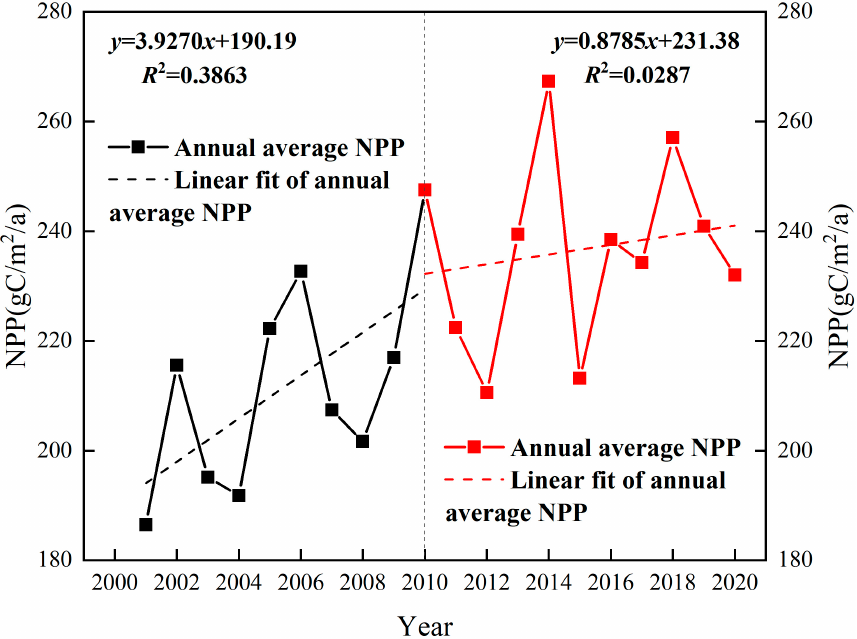
Figure 5. Trends in net primary productivity (NPP) in the Qinghai Lake Basin from 2001 to 2020.